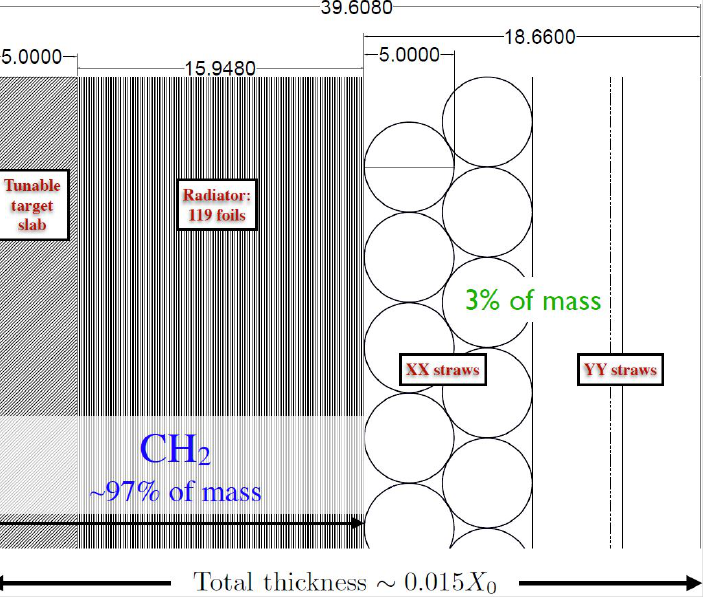
Figure 127. Drawing of a compact STT module including three main elements (left to right): a tunable polypropylene CH 2 target; a radiator with 119 polypropylene foils for e ± ID; and four straw layers